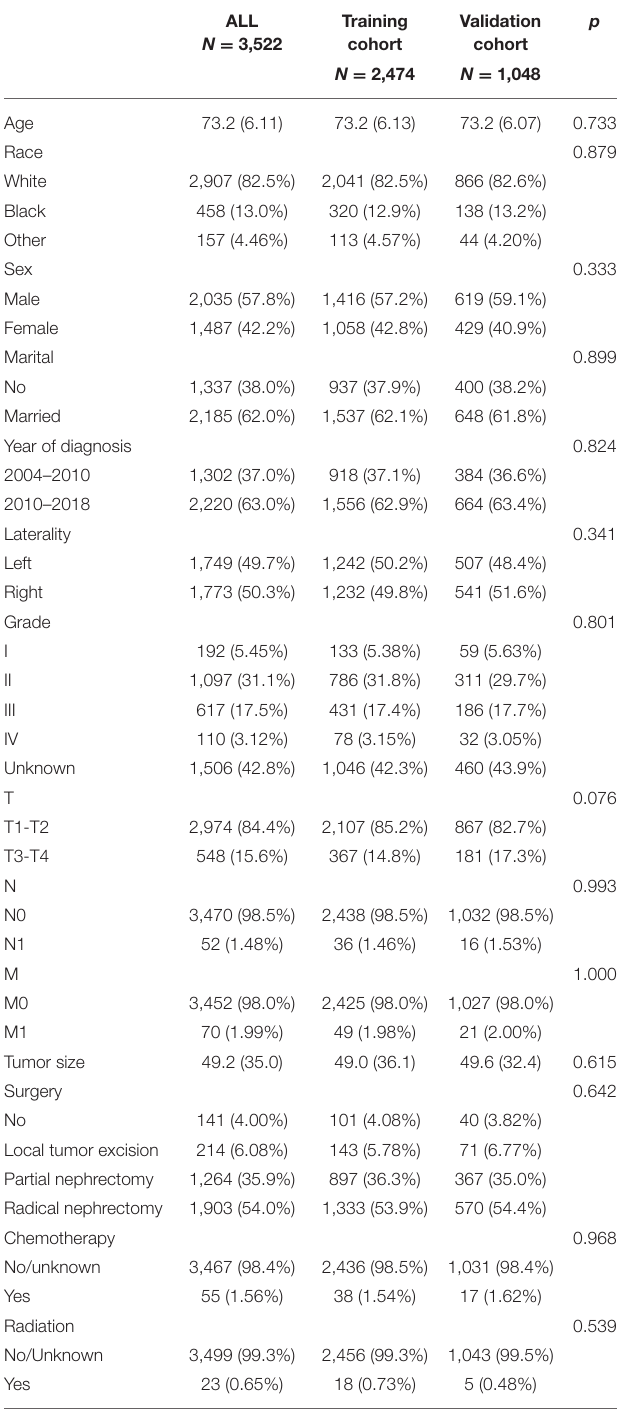
TABLE 1 | Clinicopathological characteristics of elderly patients with chRCC. ALL N =